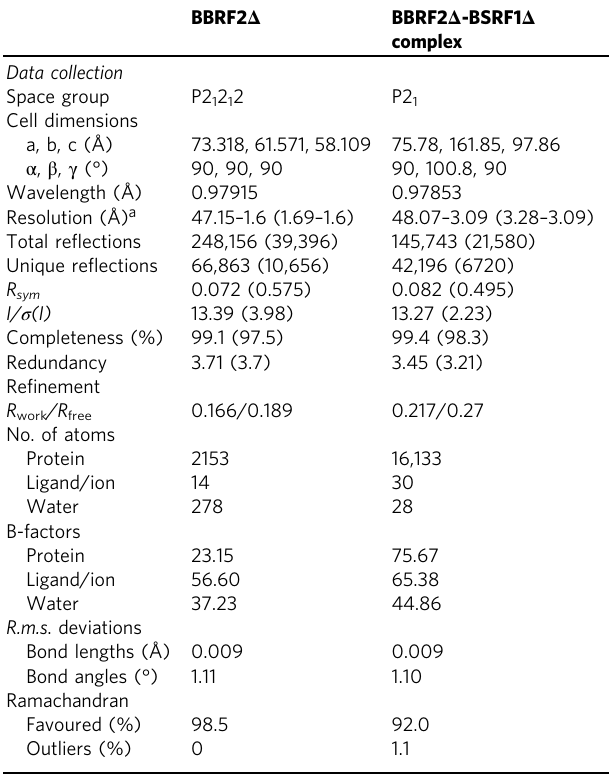
Table 1 Crystallographic data collection and re fi